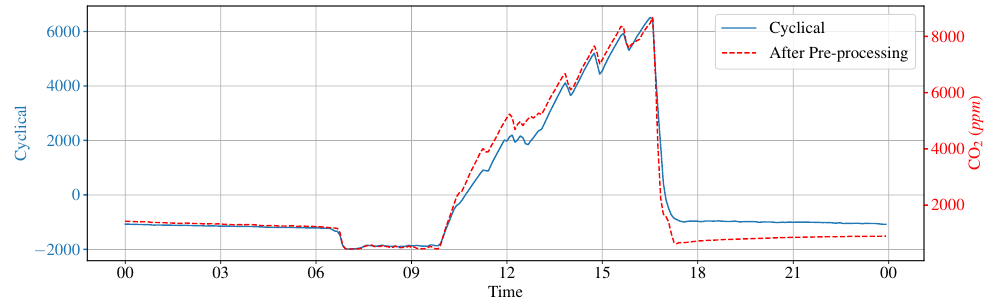
Figure 9. Cyclical component 1 day